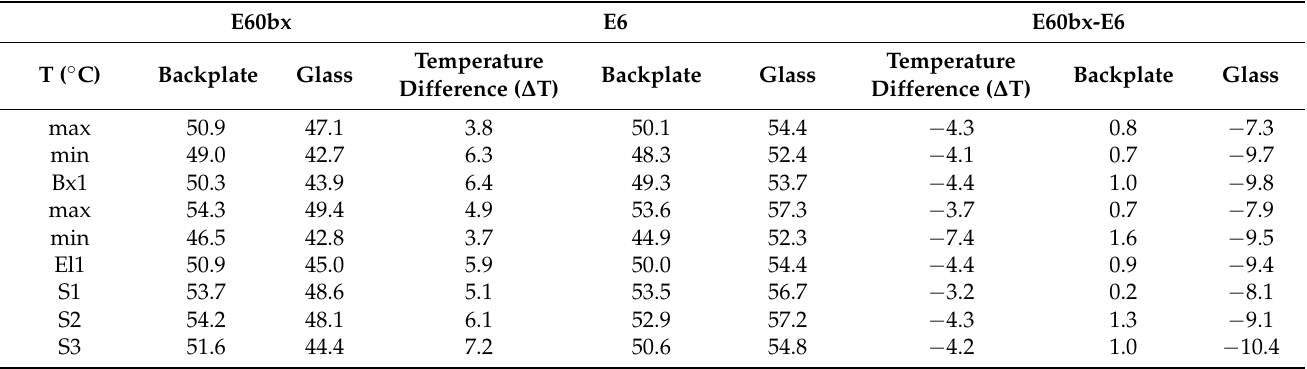
Table 3. Comparison of the apparent temperature of the glass surface and the temperature of the plastic substrate of the module.